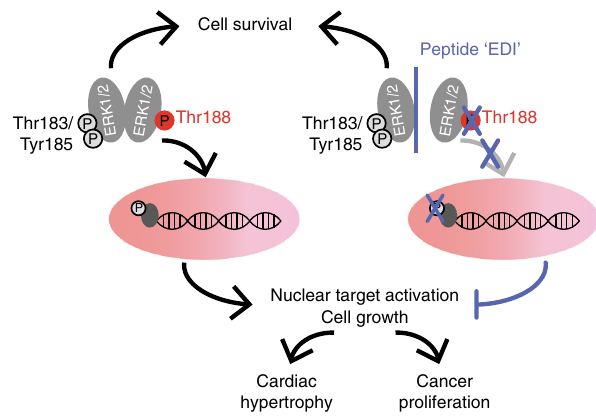
Fig. 7 Interference with ERK-dimerization at the nucleocytosolic interface. “ EDI ” interferes with ERK dimerization, thereby preventing ERK T188 -phosphorylation and nuclear ERK accumulation and signaling without interfering with ERK1/2-mediated pro-survival signals. EDI inhibits cancer cell proliferation and maladaptive cardiac hypertrophy and does not induce cardiomyocyte apoptosis and subsequent